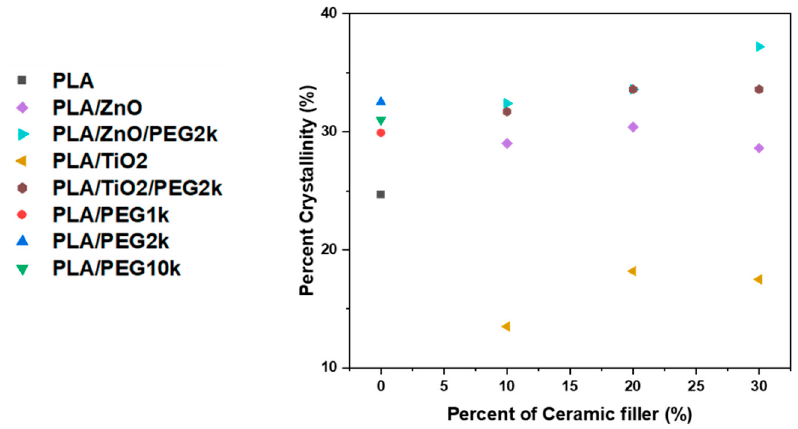
Figure 6. Crystallinity of filaments.